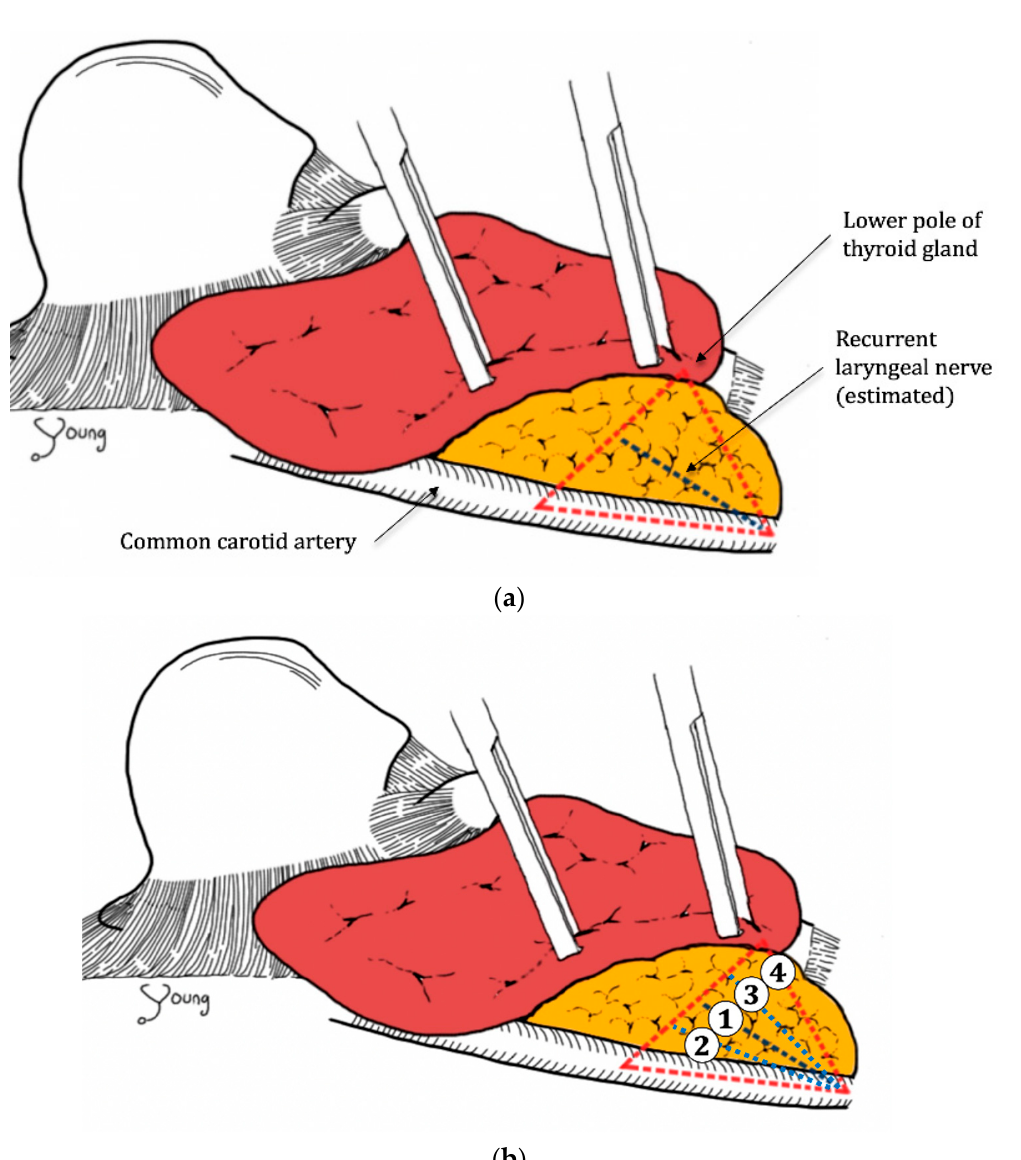
Figure 2. ( a ) The common carotid artery and lower pole of the thyroid gland form the “lower central triangle” (LCT), with the recurrent laryngeal nerve (RLN) lying in the middle of the triangle, viewed at the right lobe of thyroid with the lower pole of thyroid gland lifted. ( b ) Allocation of section numbers to characterize RLN location, viewed at the right lobe of thyroid with the lower pole of thyroid gland lifted .